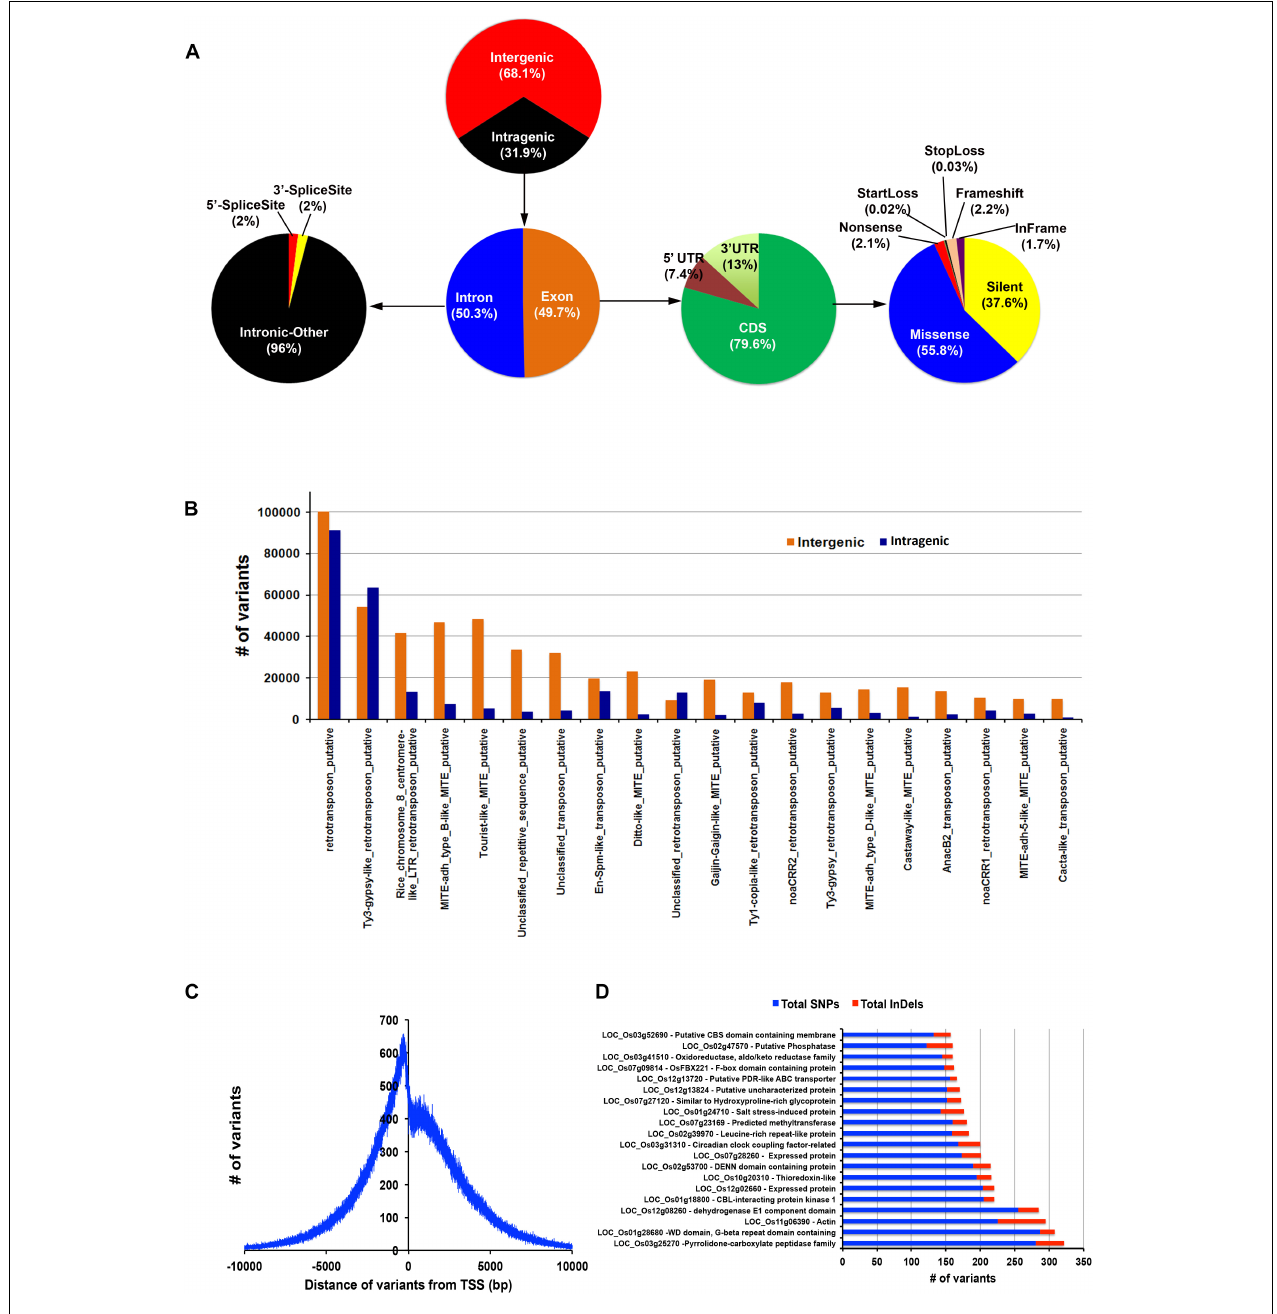
FIGURE 3 | Comprehensive variant detection and annotation. Panel (A) indicates the distribution of variants in different regions of genome. Panel (B) represents the number of variant in different types of repeats. (C) Variant density graph from transcription start site (TSS). (D) Genes containing highest SNPs/INDELs